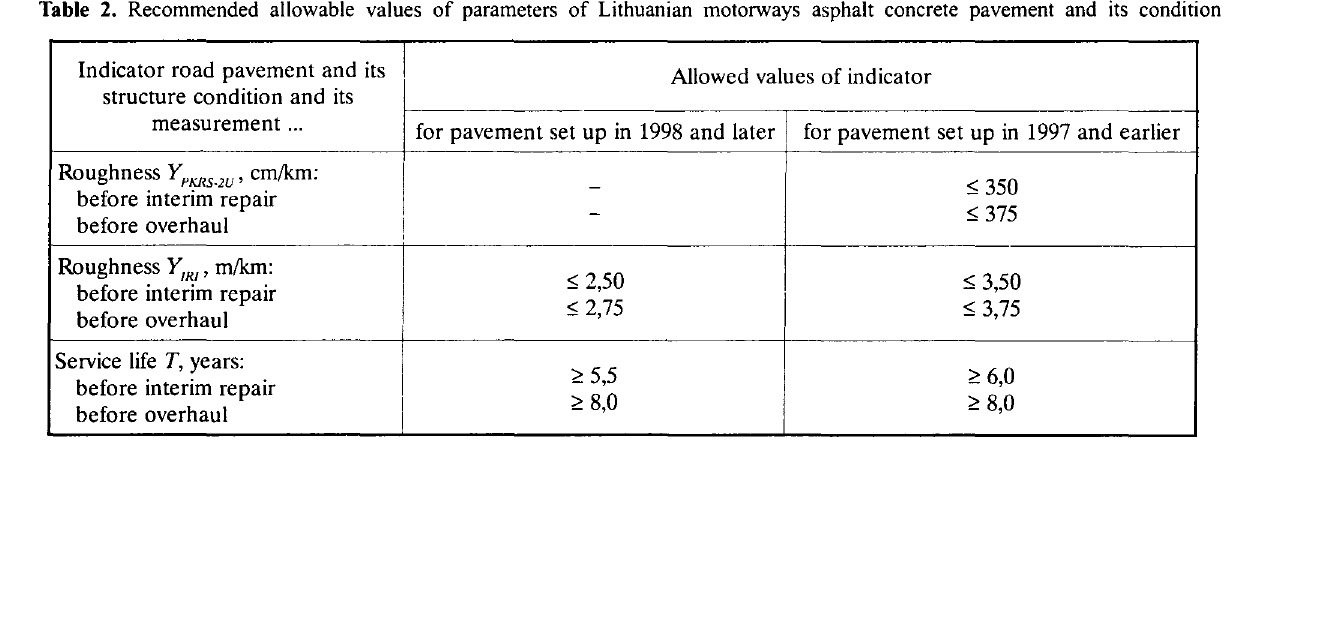
Critical levels of asphalt concrete pavement rough